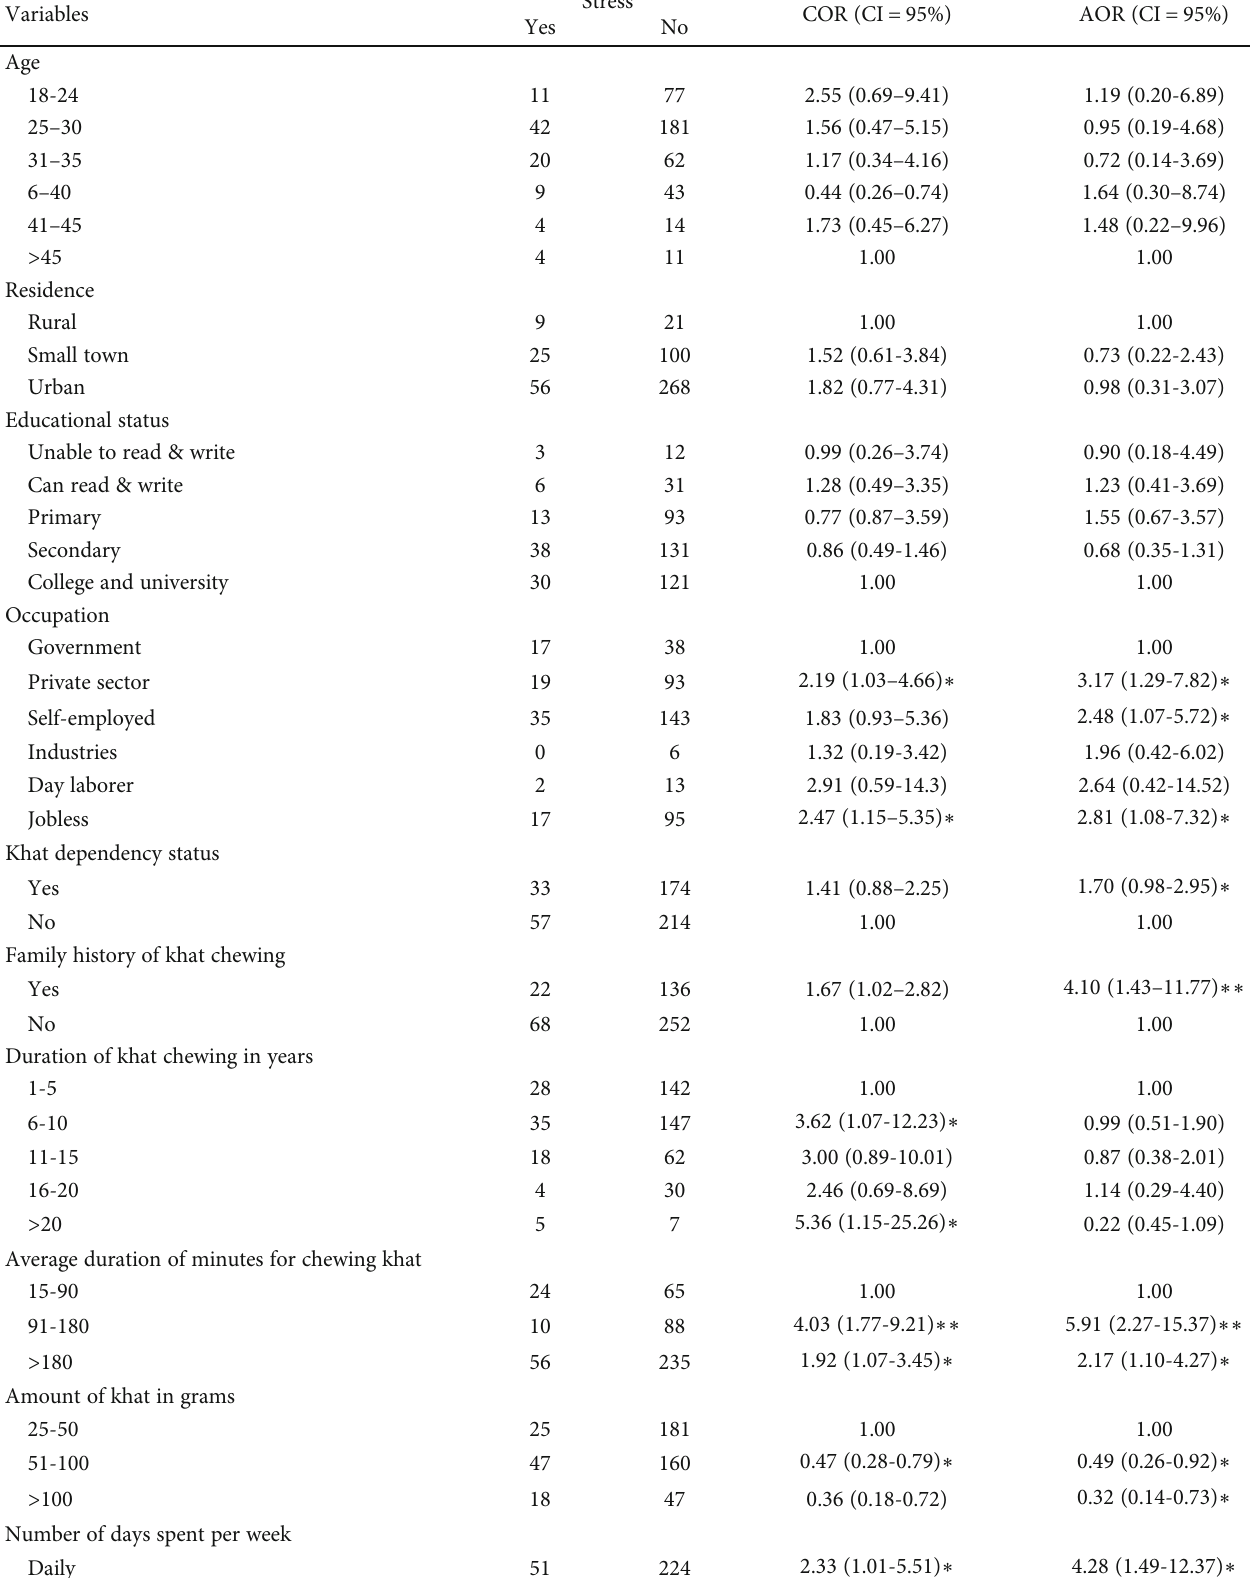
Table 4: Bivariate and multivariate logistic regression of stress and associated factors among khat chewers in Amhara region, 2019.